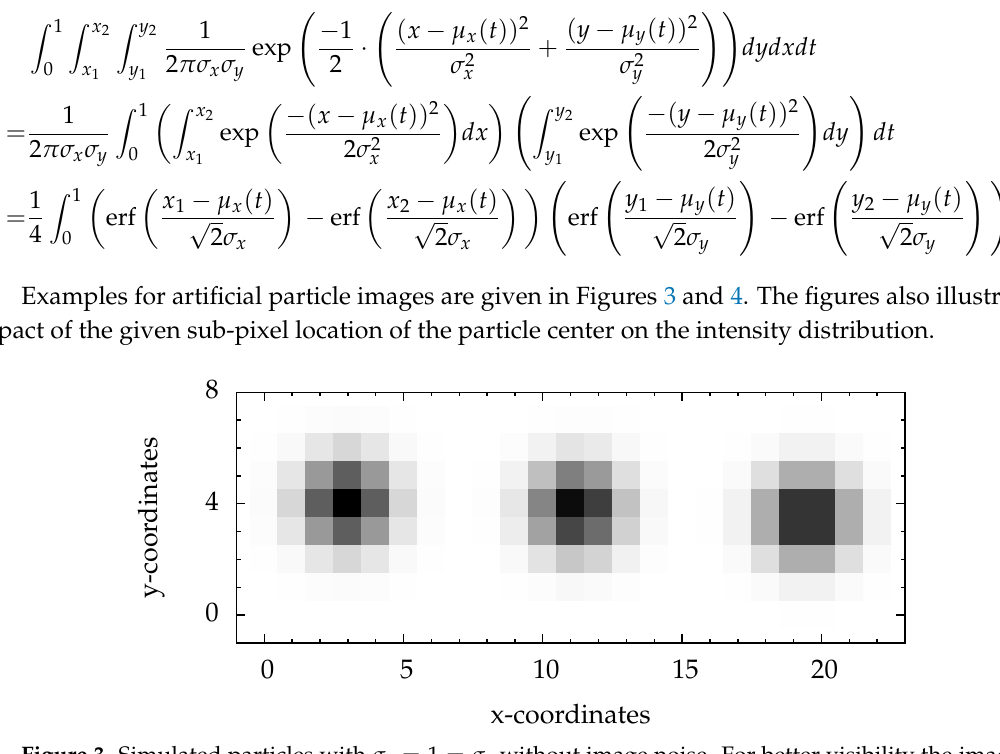
Figure 3. Simulated particles with σ x = 1 = σ y without image noise. For better visibility the image is shown in inverted colors. The coordinates ( 3,4 ) of the left particle are centered in a pixel, the coordinates ( 19.5,3.5 ) of the right particle are exactly centered between two pixels, and the coordinates ( 11.25,3.8 ) of the middle one are chosen arbitrarily.